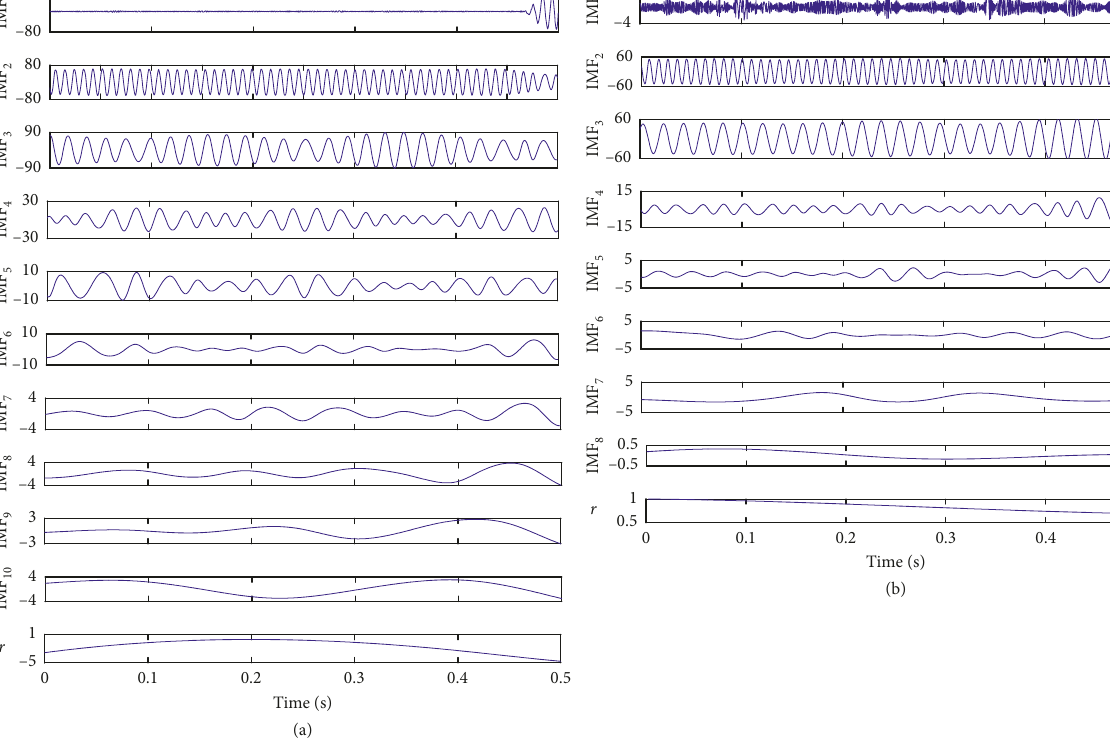
Figure 6: The decomposition results of signals x and y using